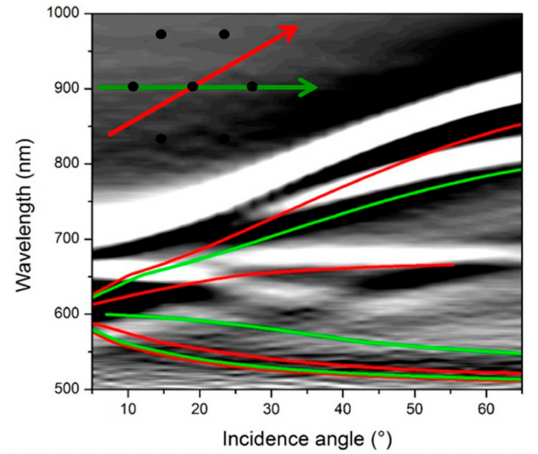
Figure 5. Second derivative of the spectral reflectance plotted as a function of the incident angle. The bright and dark signals correspond to minima and maxima in the reflectance spectrum, respectively. The superimposed red and green lines correspond to the calculated plasmonic dispersion for two orientations of the hexagonal